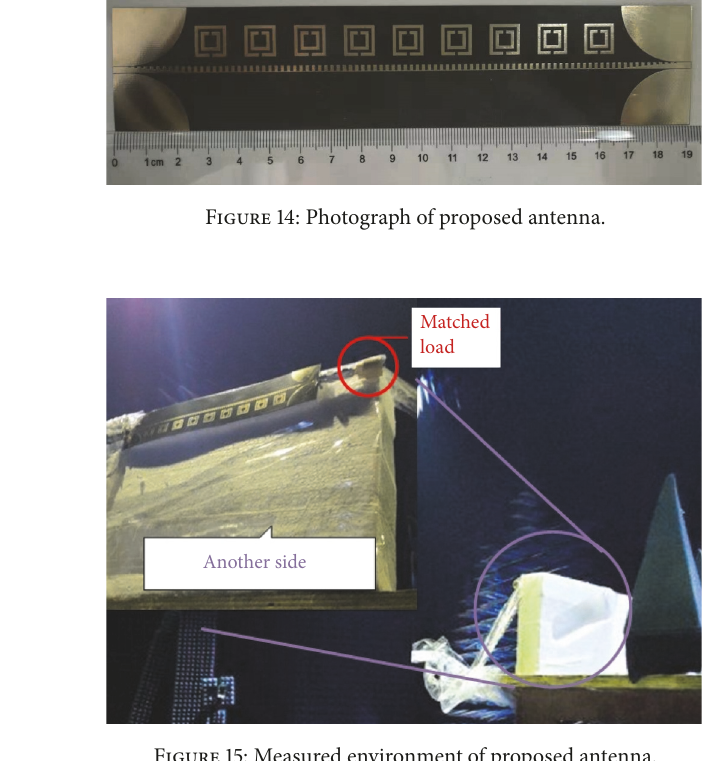
Figure 15: Measured environment of proposed